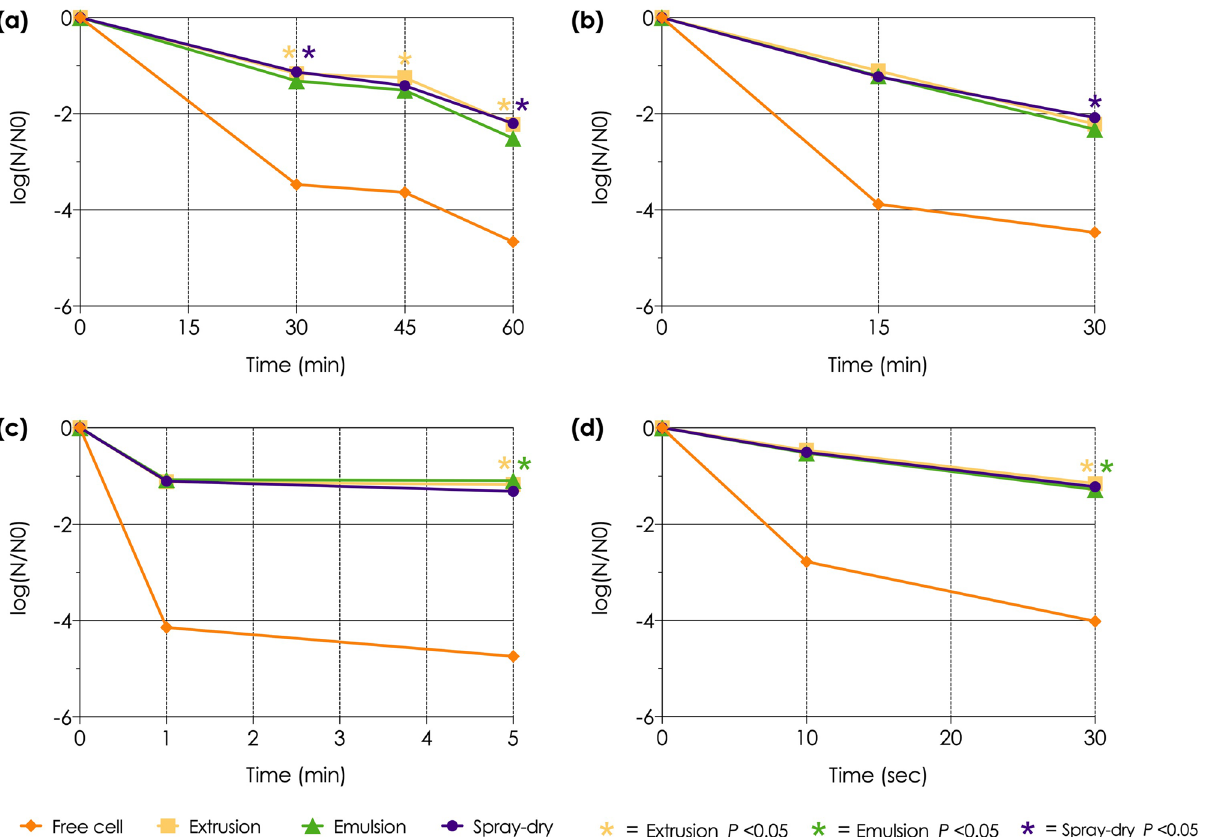
Figure 3. Comparison of survival between the non-capsulated and differently encapsulated L22F strains after heat treatment at ( a ) 60 °C, ( b ) 70 °C ( c ) 80 °C, and ( d ) 100 °C. The spray drying procedures were performed under an inlet temperature of 130 °C. The asterisks represent statistically significant differences ( P < 0.05). The yellow, green, and purple asterisks represent the significance of the extrusion, emulsion, and spray-drying methods, respectively.